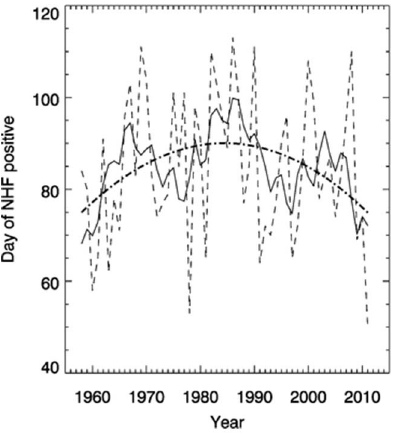
Figure 3. Onset of spring bloom day, determined using the NHF calculation (dashed line), between 1958 and 2011 at station E1. The solid line represents a spectral analysis of the NHF calculated, day of bloom onset, time-series using a Box-Jenkins [30] approach. The dash-dot line is a statistically significant (p=0.004; r=0.294) long-term cycle.